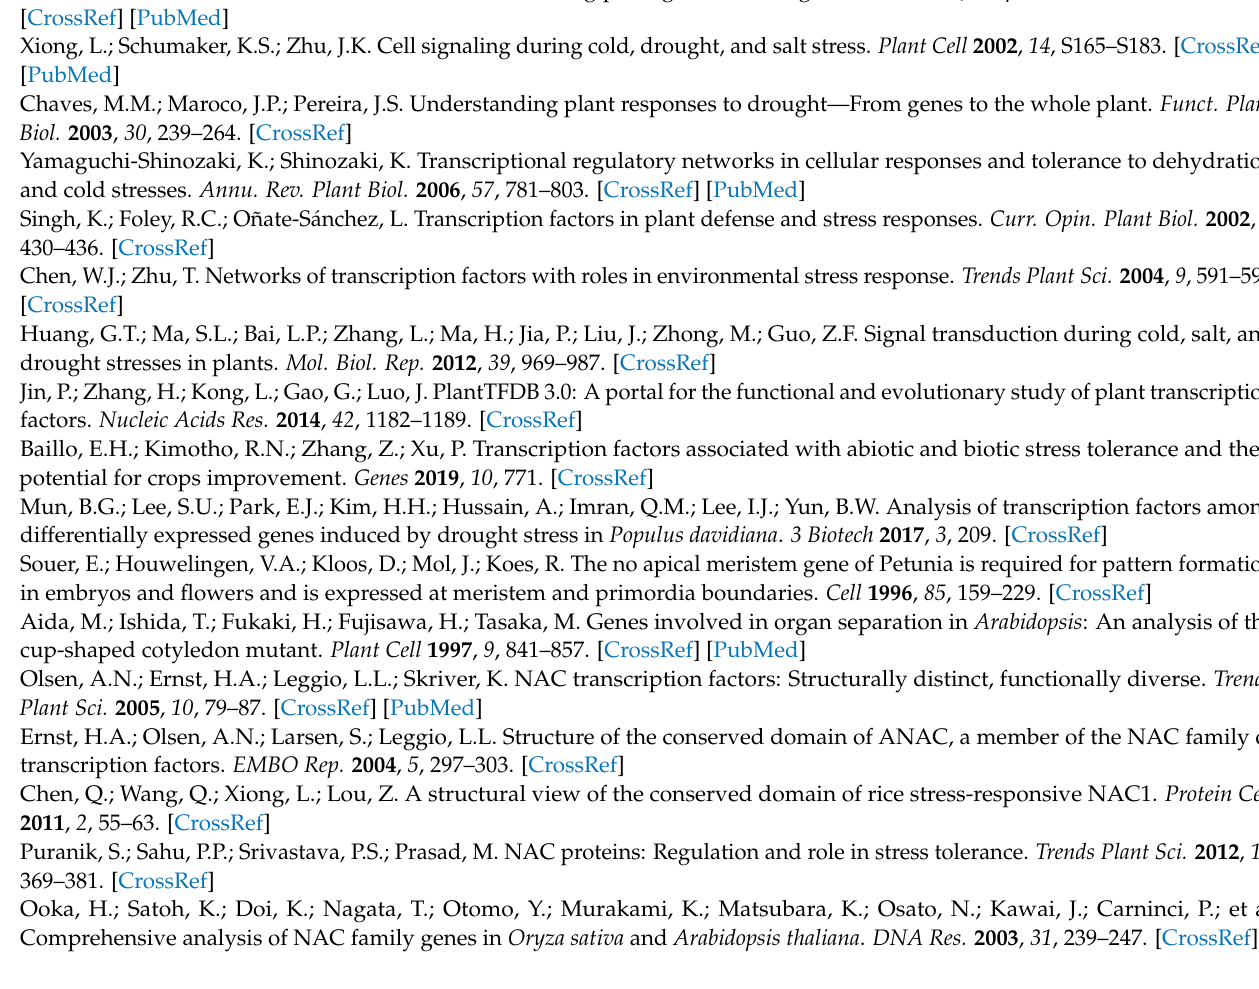
time PCR in this study. Table S2: Cis -acting element of DcNAC gene promoters. Table S3: Expression of DcNAC genes in different tissues. Table S4: Expression of DcNAC genes under drought stress (TPM). Table S5: Sequences of the network proteins. Table S6: Information of the network